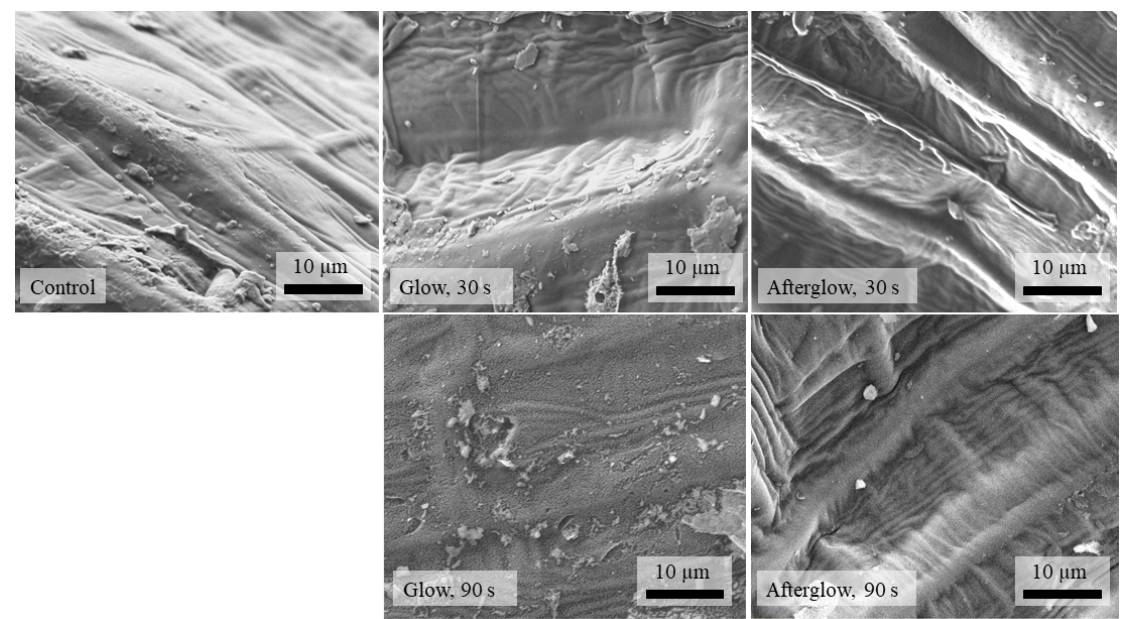
Figure 2. Representative SEM images of control wheat seeds and seeds treated with glow and afterglow CP for 30 s and 90 s.